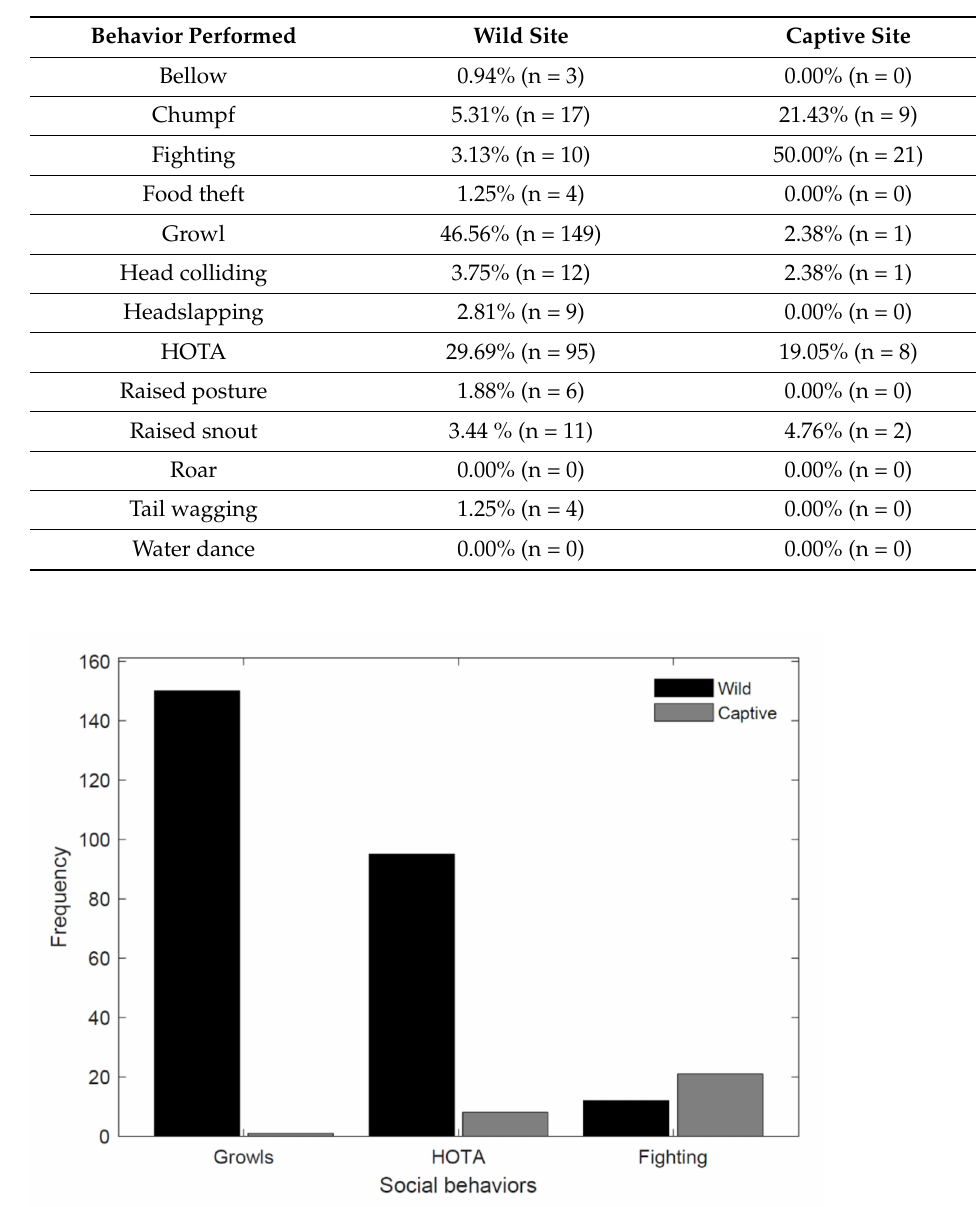
Table 1. The proportion of each social behavior at each site, presented as the percentage of each type of social behavior divided by the total number of social behaviors performed at that site with behavior counts in parentheses (n = 320 for the wild site and n = 42 for the captive site; data collected 09:00–14:30).